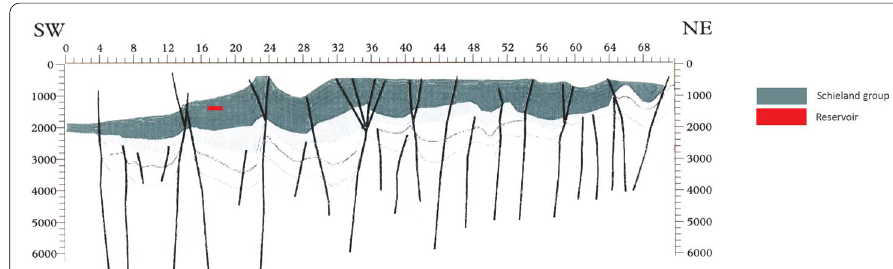
Fig. 1 Typical SW-NE geological cross-section through the WN, after van Balen et al. (2000). The location of the hypothetical reservoir considered in this study is tentatively indicated with a red rectangle. For the exact location of the cross-section, see van Balen et al. (2000)